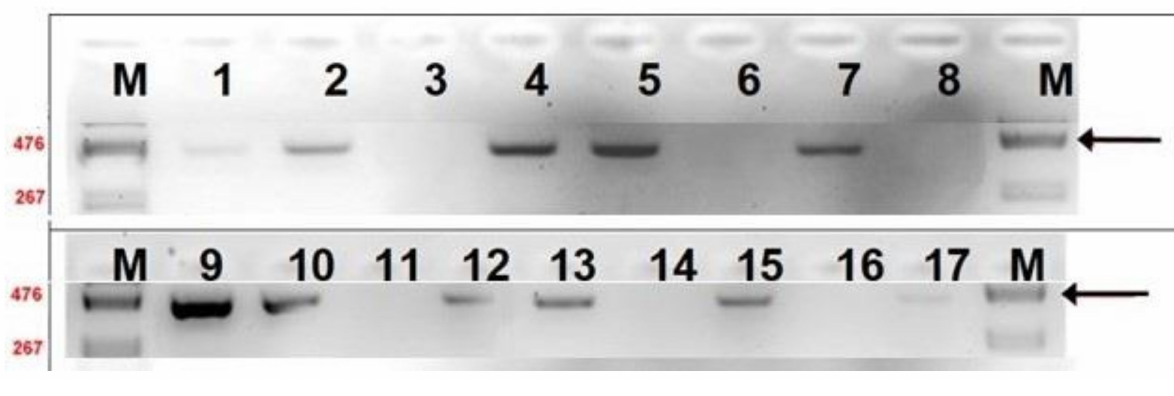
Figure 5. Analysis of sex marker Sry in foetuses by PCR reaction. M: DNA size marker 1, 2, 4, 5, 8, 9, 13: normal foetuses; 14, 15: foetuses delayed 0.5–2 days; 3, 10, 12, 16: delayed foetuses; 6, 7, 11, 17: degenerating